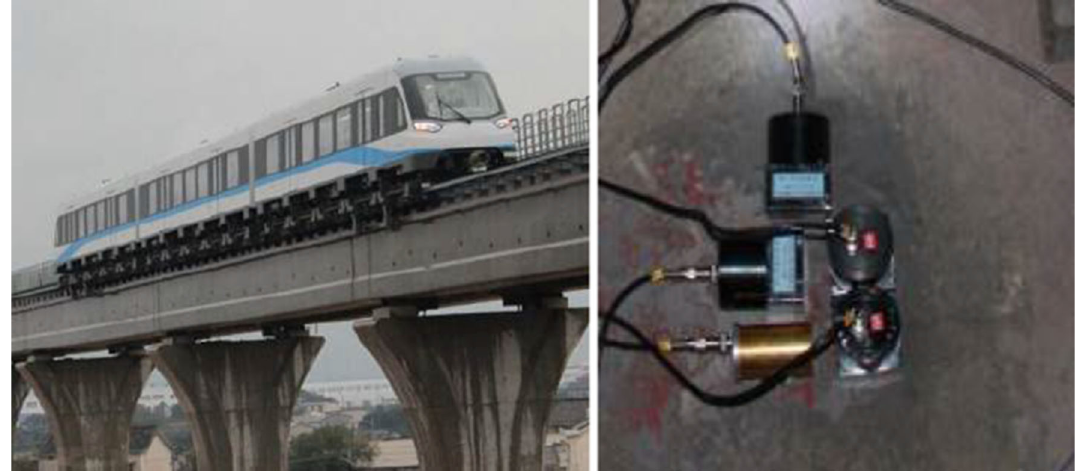
Fig. 6 Photographs of the field